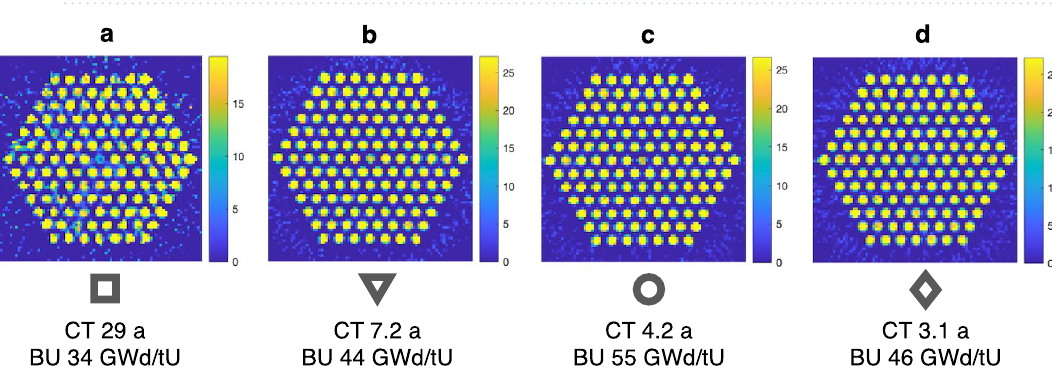
Figure 7. Reconstructed gamma activity images in the 1200–1300 keV window for the same four VVER-440 assemblies ( a – d ) as in Fig. 6b. Symbols used in Fig. 6b to denote the assemblies are shown below each image here, along with the CT and BU